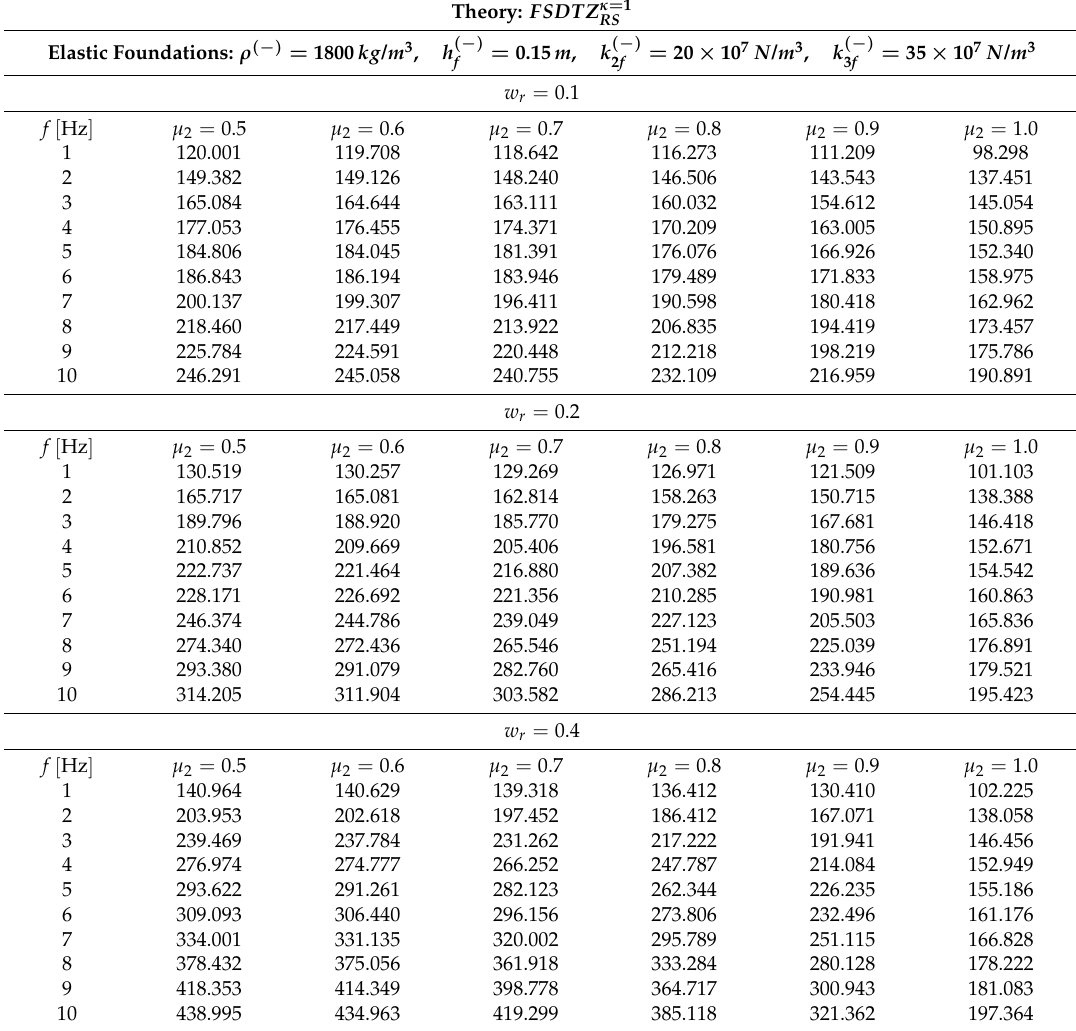
Table 16. First ten natural frequency variations for FSDTZ κ = 1 (Figure 4c) reinforced by CNTs distributed as in Figure 5c for different mass fractions w r when varying the parameter of agglomeration µ 2 with µ 1 = 0.5. The Chebyshev-Gauss-Lobatto grid distribution was employed, with I N = 31, I M =